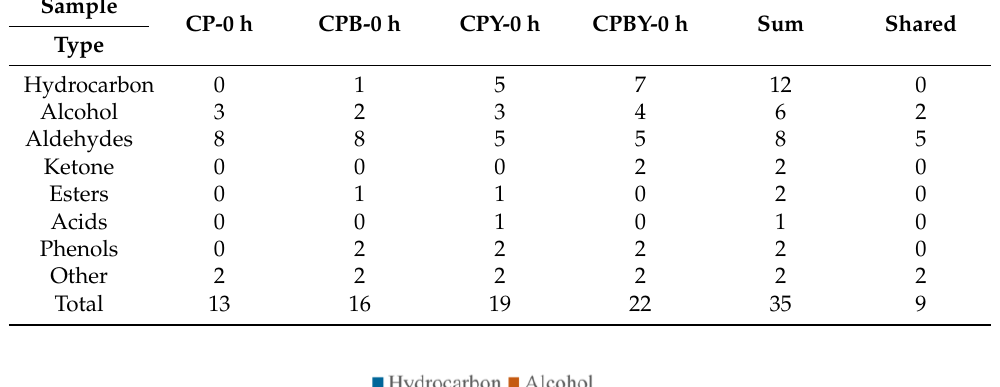
Table 3. Types of volatile odor substances in four groups of unfermented specimens.